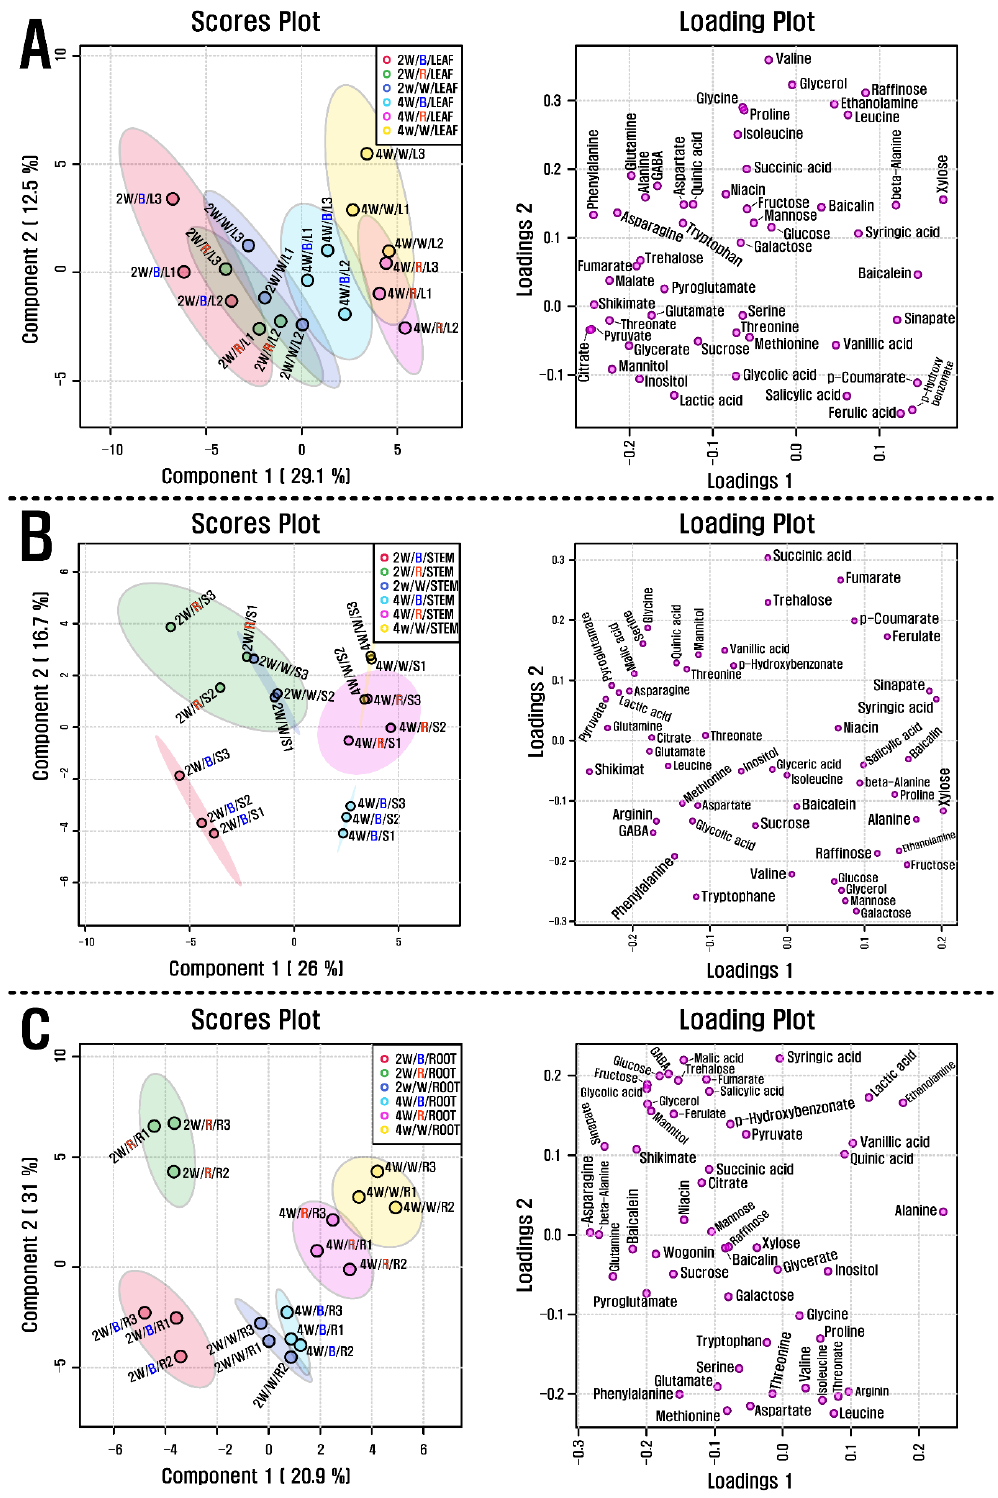
Figure 2. ( A ) Scores and loading plots of the PCA model using metabolites from the leaves of S . baicalensis seedlings grown under the LED treatment of varying duration, ( B ) Scores and loading plots of the PCA model using metabolites from the stem of S . baicalensis seedlings grown under the LED treatment of varying duration, and ( C ) Scores and loading plots of the PCA model using metabolites from the root of S . baicalensis seedlings grown under the LED treatment of varying duration. 2 w and 4 w indicate 2 weeks and 4 weeks, respectively, as well as B, R, and W indicate blue, red, and white, respectively.